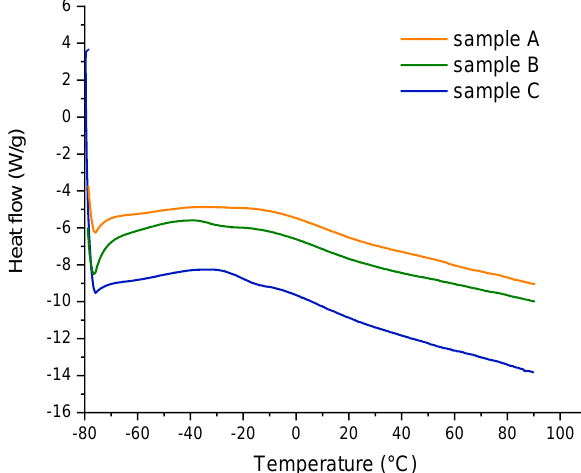
Figure 7. Differential scanning calorimeter testing routine.